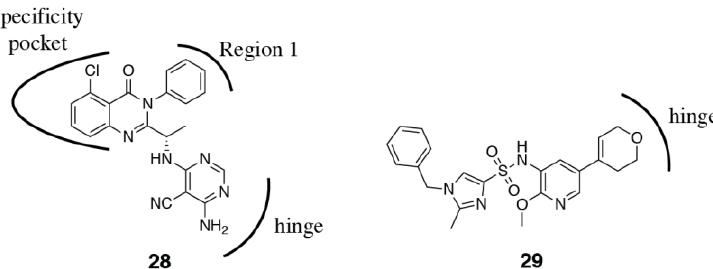
Figure 5. Structures of 28 and 29 , which demonstrate differences in hinge-binding moieties that affect isoform selectivity.